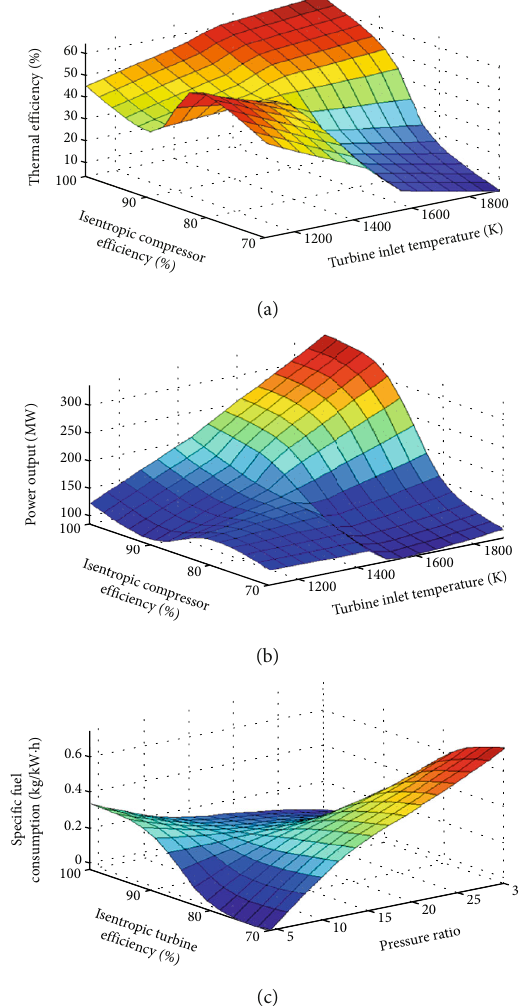
Figure 14: Predicted performance of the RGT with optimum parameters: (a) thermal e ffi ciency, (b) power, and (c) speci fi c fuel